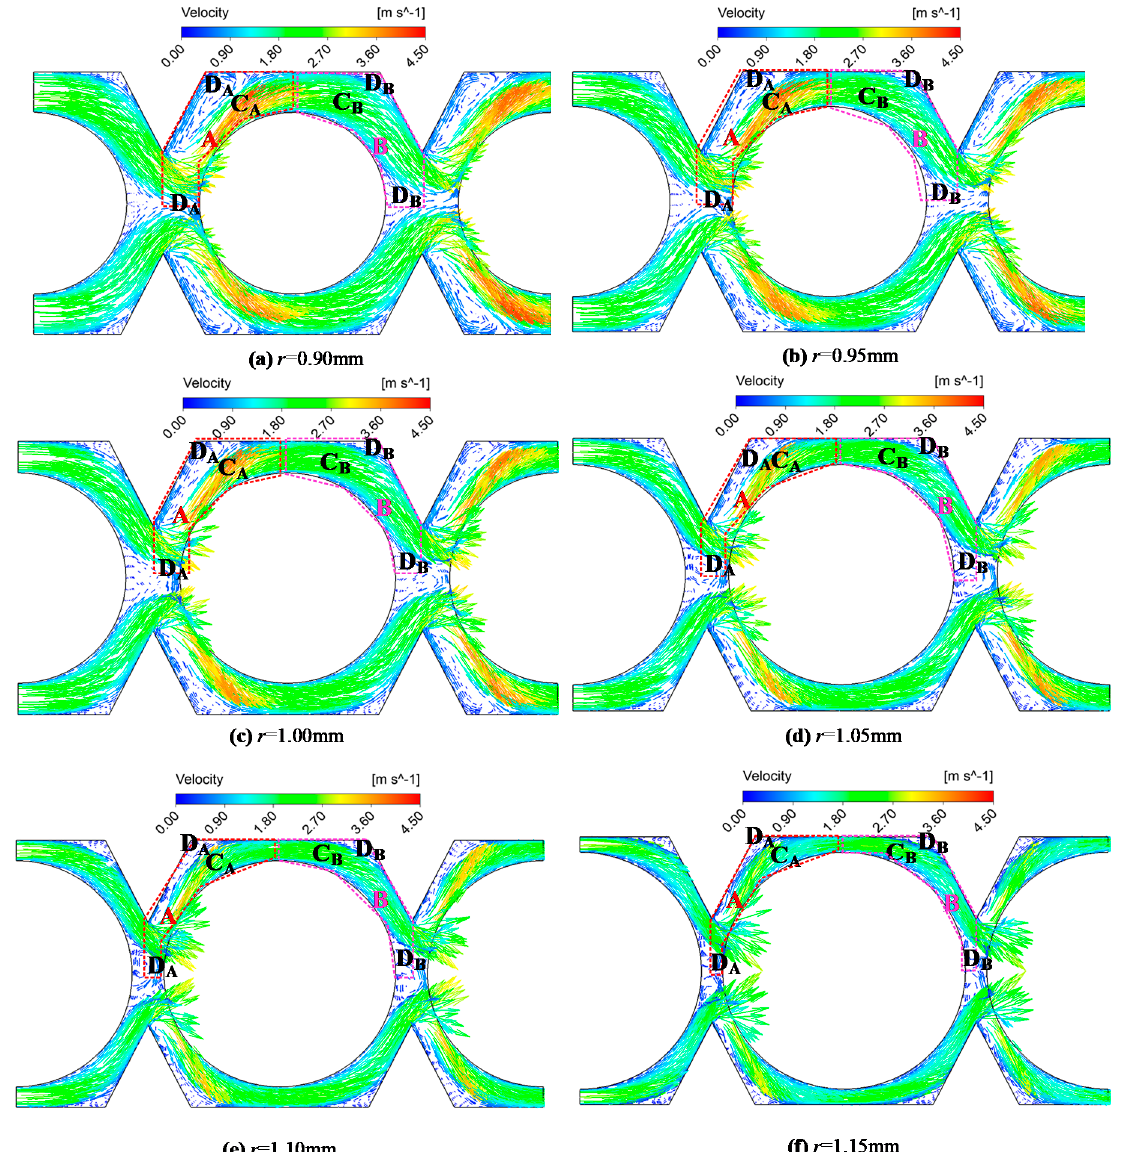
Figure 6. The mid-depth cross sectional velocity vector distributions of the fourth flow channel unit for six flow channels under 100 KPa.